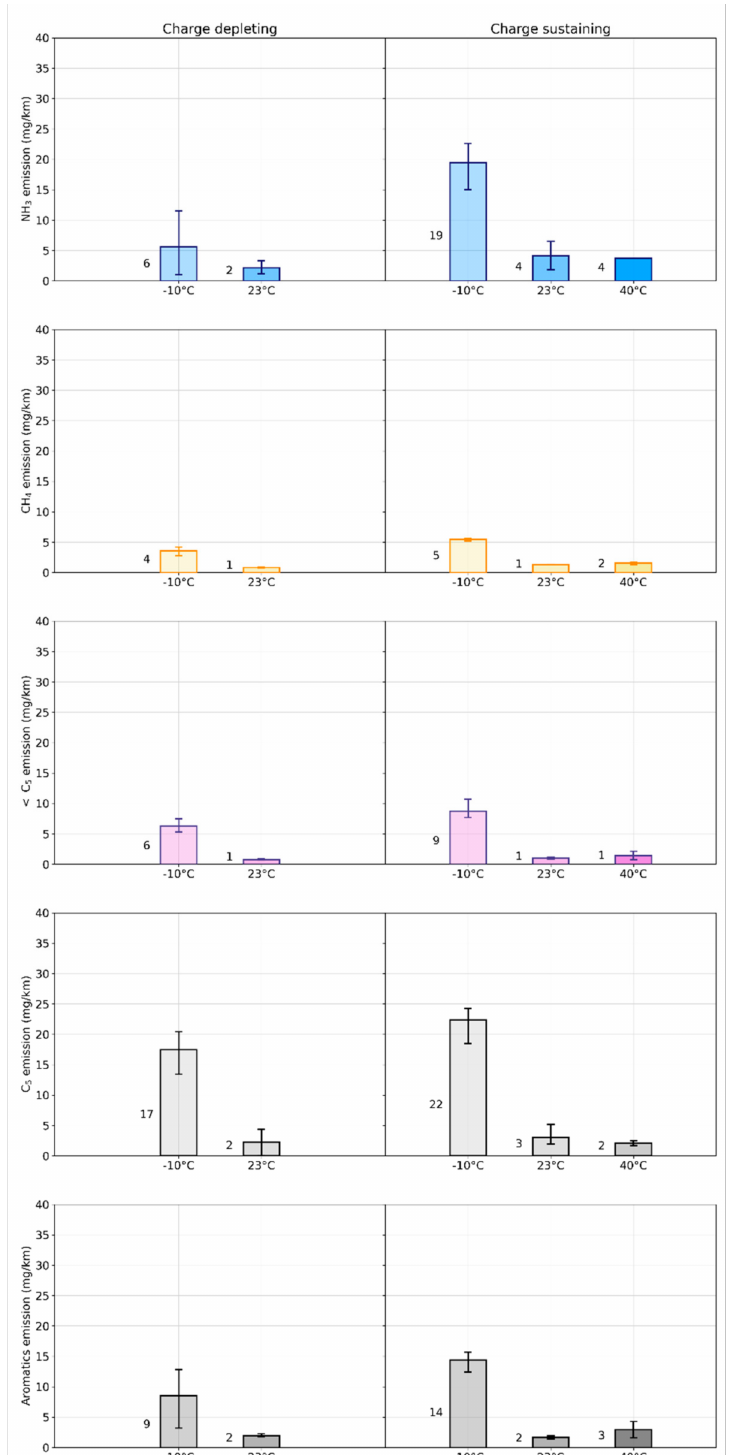
Figure 5. Emissions of unregulated pollutants (NH 3 , CH 4 , <C 5 , C 5, and aromatics hydrocarbons) in WLTC tests as a function of temperature. CD indicates the cycle in the charge-depleting sequence, started with an initial battery state of charge (SOC) equal to 100%, in which the internal combustion engine ignited for the first time (3rd cyle at 23 ◦ C, 1st cycle at − 10 ◦ C); CS indicates the cold-start charge-sustaining cycle performed after the battery depleting sequence. All tests were performed in the default user-selectable mode of operation. Error bars on the graph represent maximum and minimum values. See the Methods section for additional